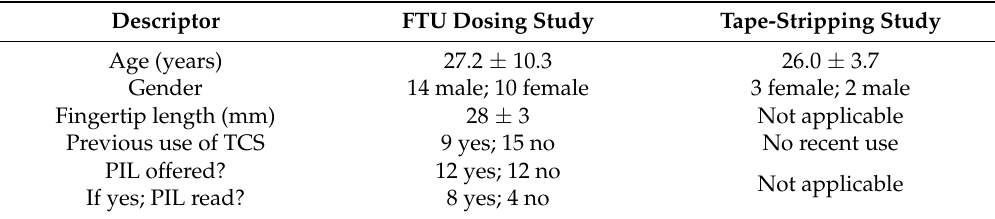
Table 1. Key descriptors of the two subject populations that participated in the two studies.